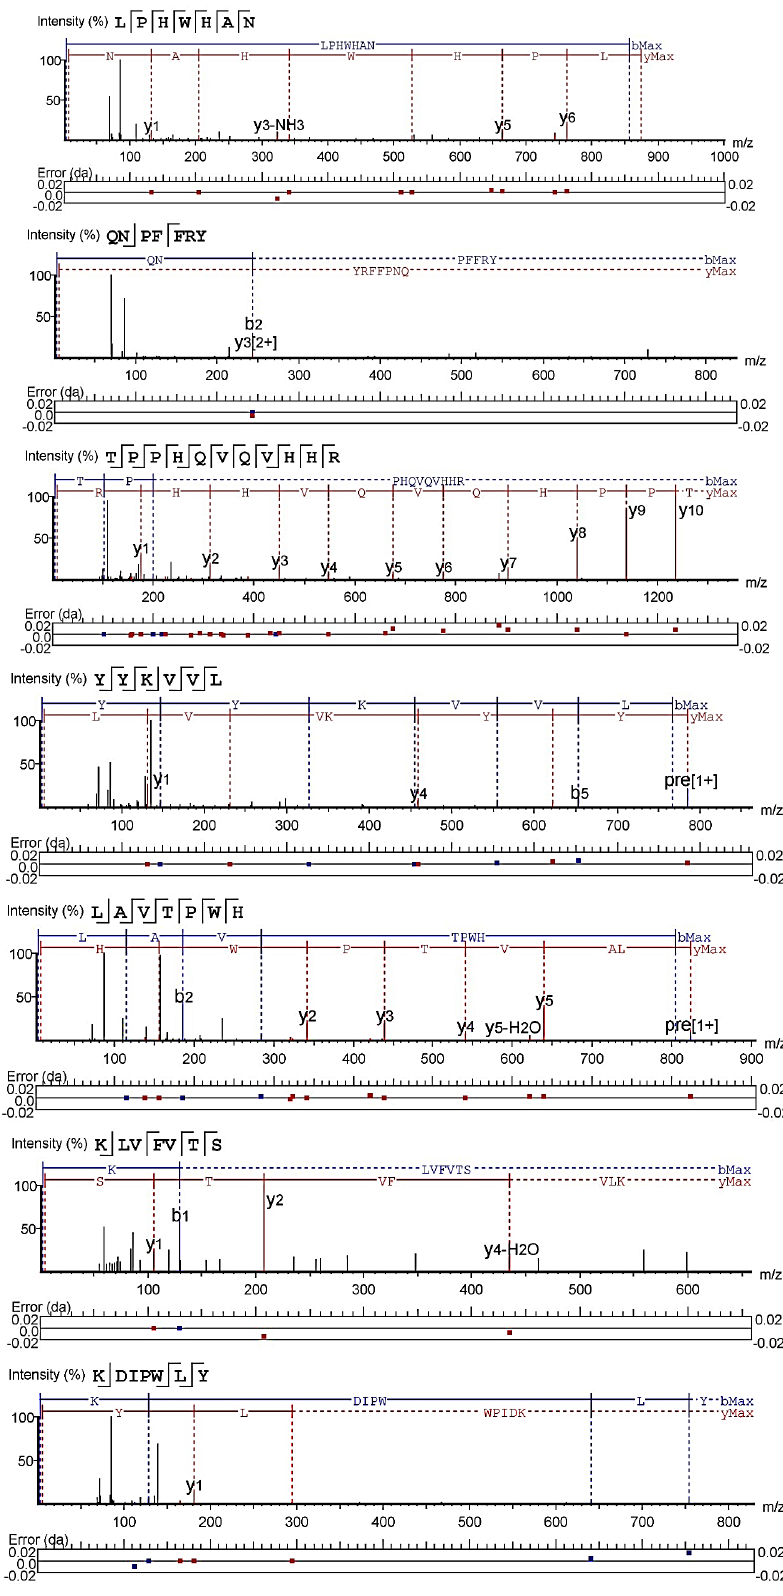
Figure 1. MS/MS diagram of pancreatic lipase inhibitory peptides identified from hydrolysates and the hydrolysates separated by ultrafiltration affinity